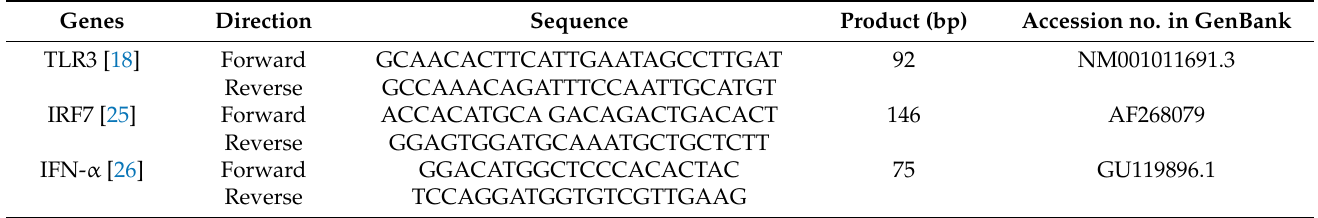
Table 2. Sequences of primers used for quantitative reverse transcription-polymerase chain reaction for detection of chicken and IBDV genes of